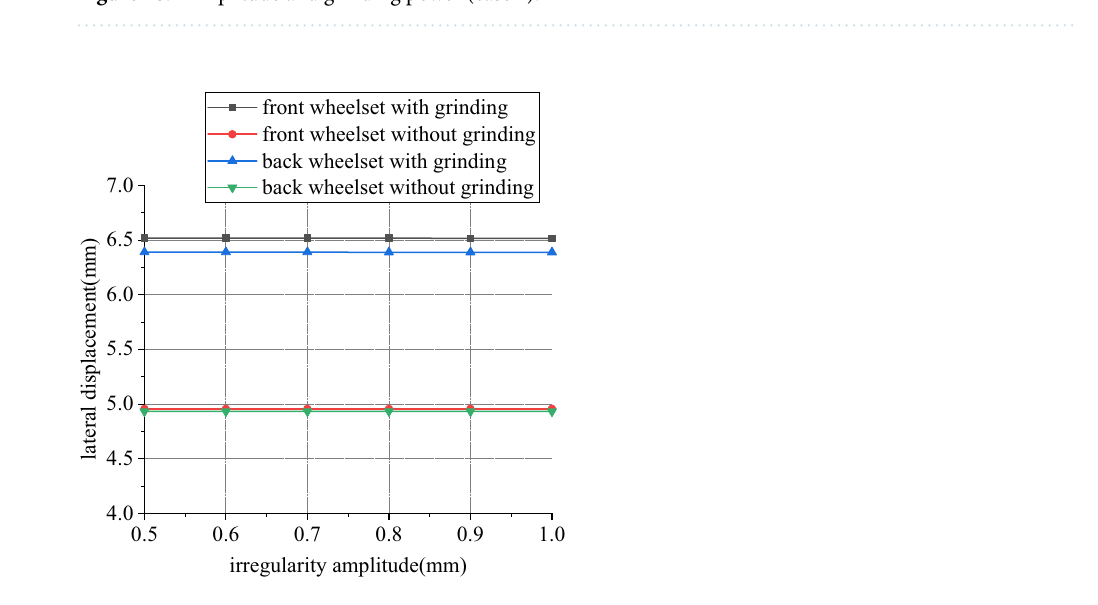
Figure 19. Amplitude and lateral displacement (case